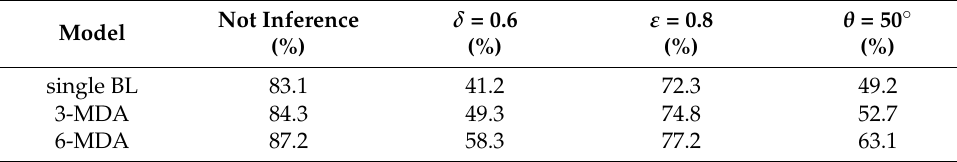
Figure 9. Performance with different random disturbances corresponding to the mr -MDA, the BLs, and the plain MDA. The subfigures ( a ) to ( c ) respectively represent the curves of the test accuracy under shifting, scaling, and rotating disturbance. The subgraphs ( d ) to ( g ) respectively denote the phase image of one diffractive layer of the mr -MDA trained by shifting (δ = 0.6), scaling (ε = 0.8), and rotating (θ = 50°), and the standard (δ = 0, ε = 0, θ = 0) training dataset. Table 1. The accuracy of different models under specific circumstances.